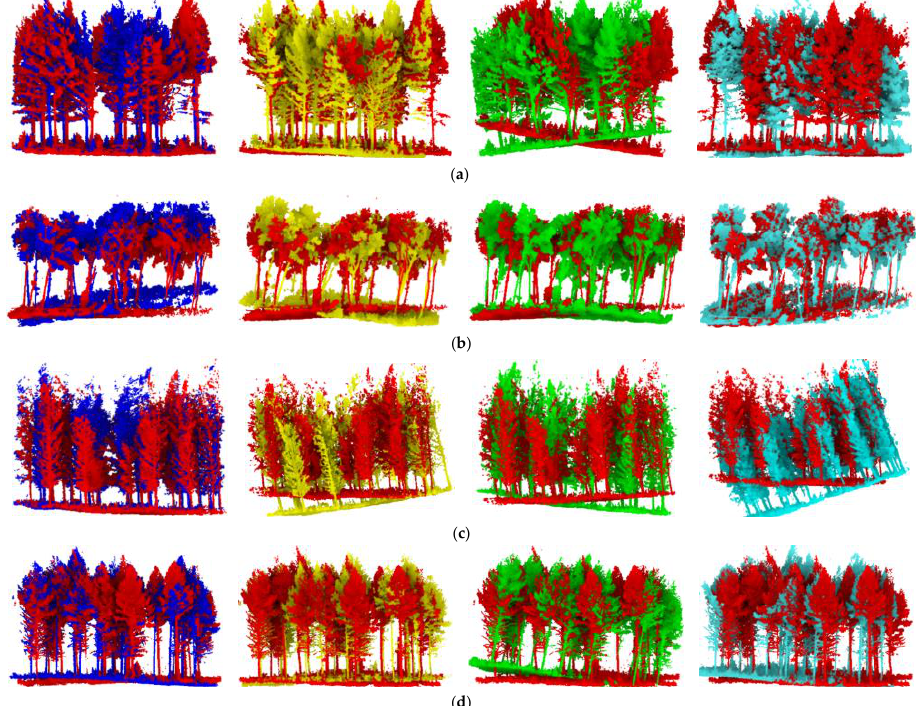
Figure 4. Coarse alignment of the TLS point clouds (non-red points) scanned at the four corners and the reference (red points). ( a – d ) represent the alignment results in Datasets 1, 2, 3, and 4, respectively.